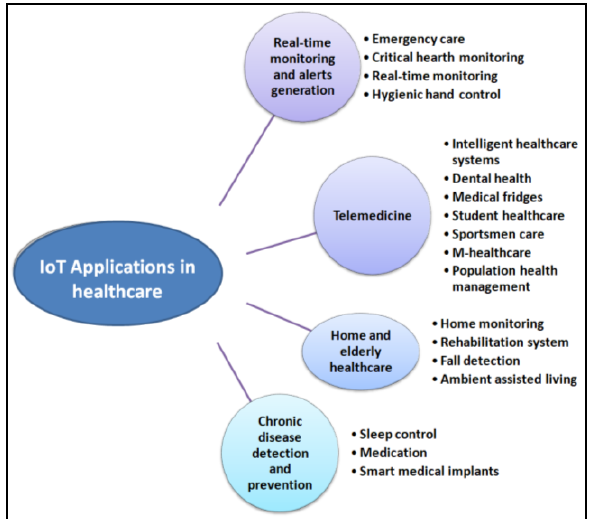
Figure 8. Different Application Fields of Smart Healthcare Systems (Naresh et al., 2020)